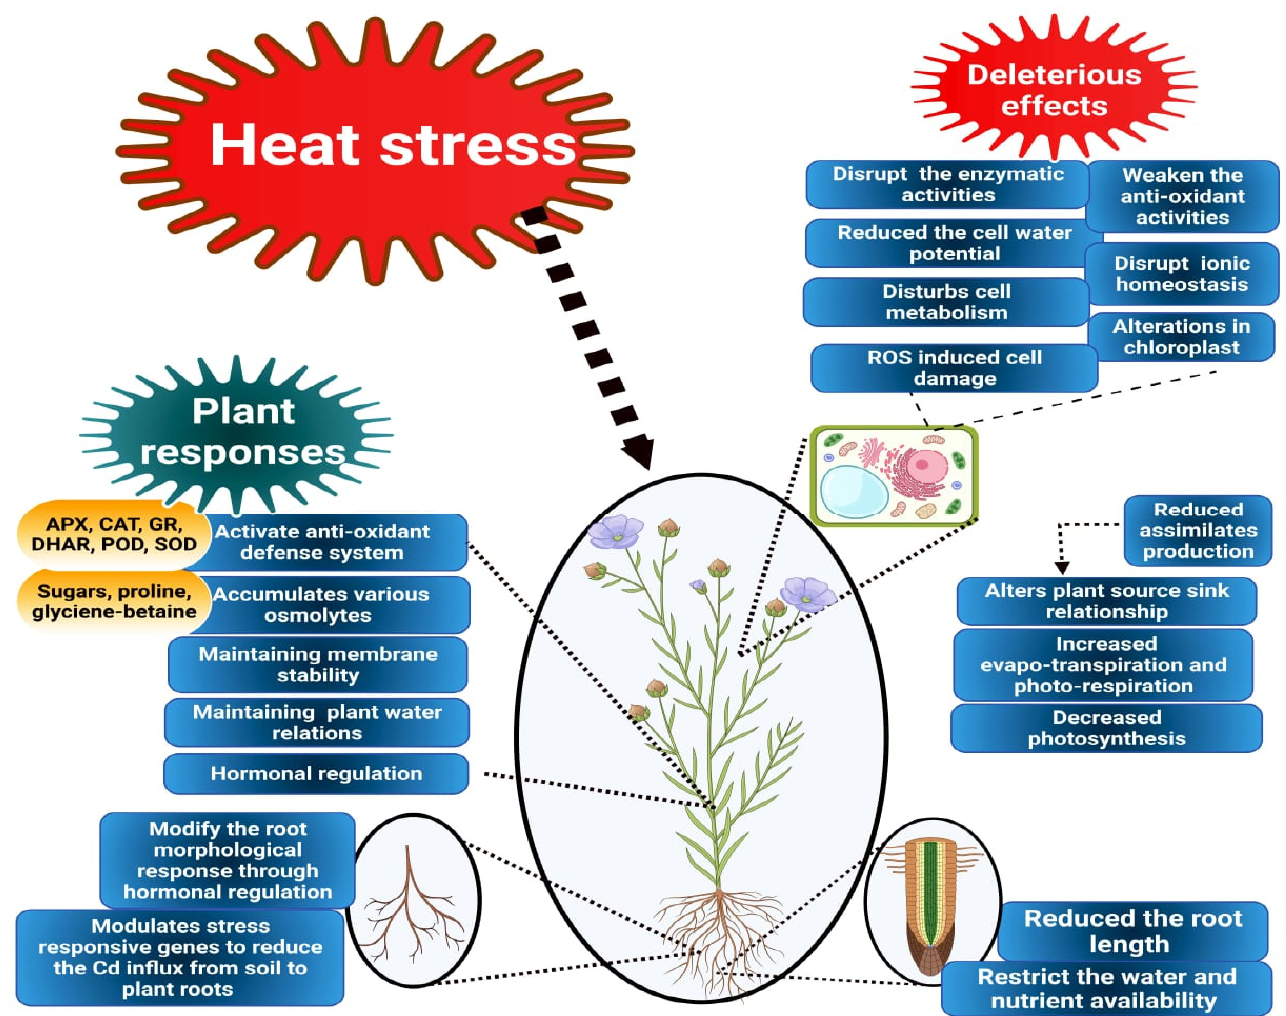
Figure 1. Effect of HS stress on plants. HS disturbs cell membranes, plant physiological functioning, photosynthetic efficiency, reduces assimilate production, alters source–sink relationships, root growth, nutrient and water uptake, and results in reduction in growth and yield. Moreover, HS, also dustups enzymatic activities, ionic homeostasis, antioxidant activities, and induces production of ROS, which causes huge growth and yield losses.